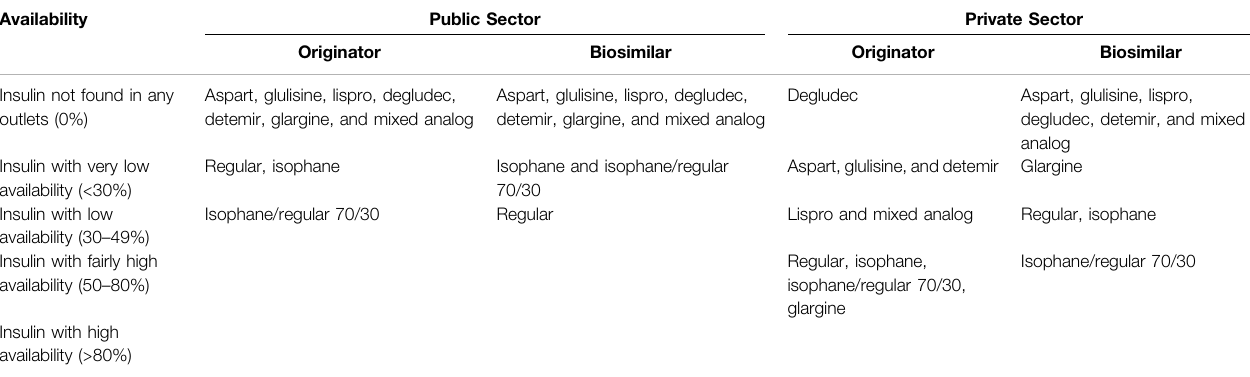
TABLE 2 | Availability of insulin products in public and private